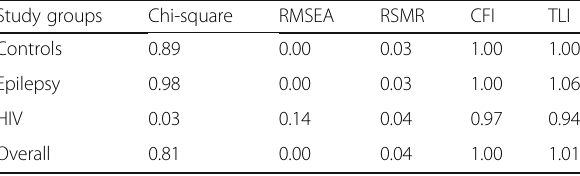
Table 2 Fit indices from confirmatory factor analysis of the WHO-5 well-being index summarized by chronic illness status Study groups